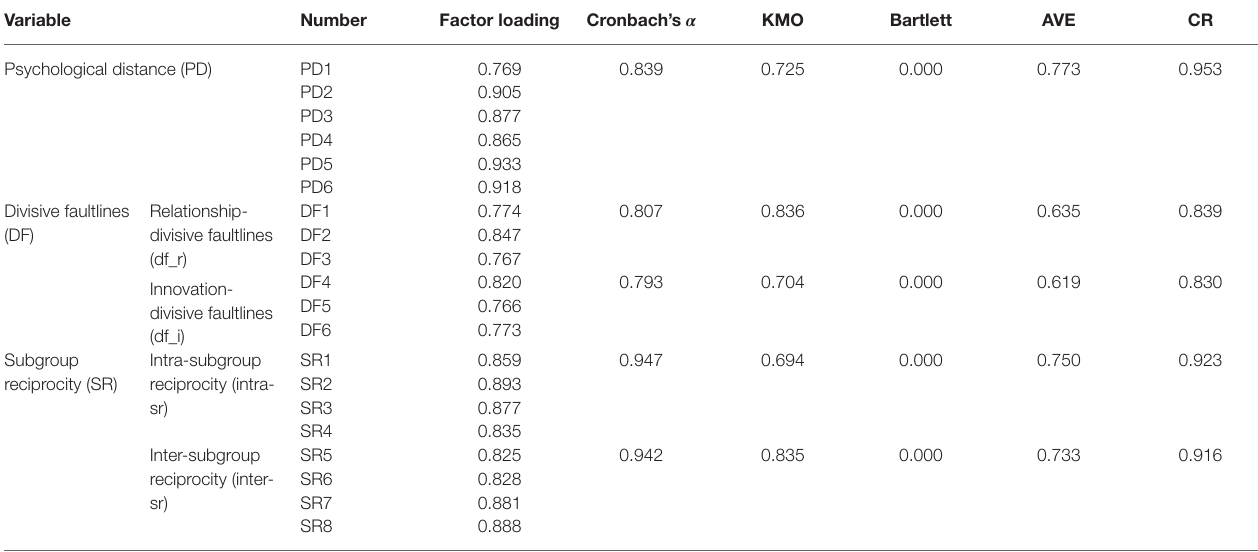
TABLE 2 | Tests of reliability and validity.